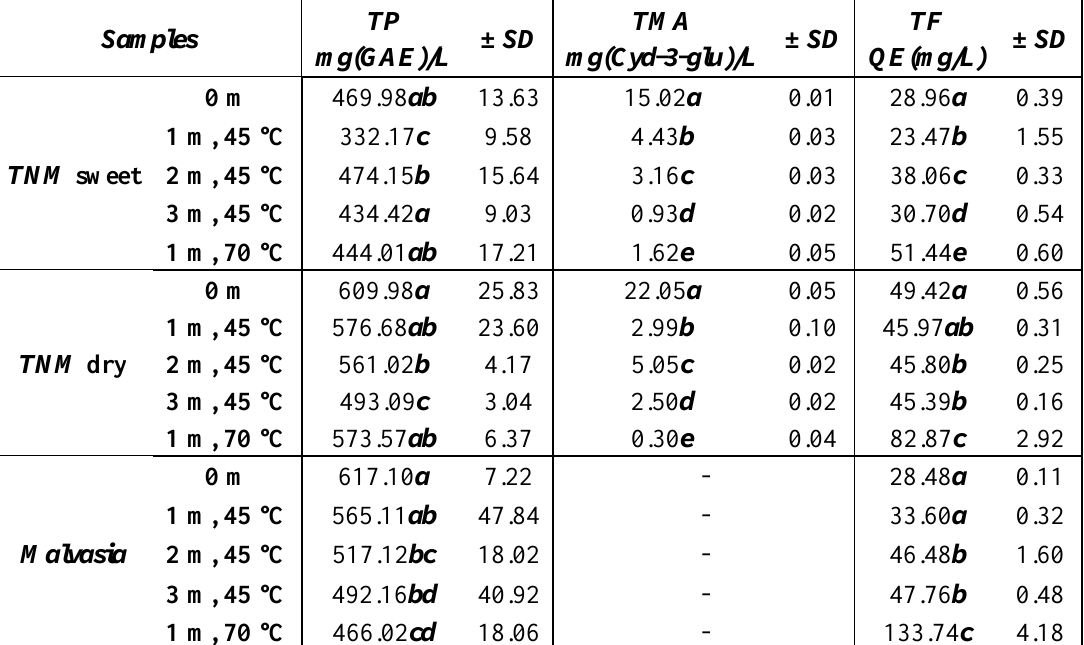
Different letters in the same column means significant differences at p <